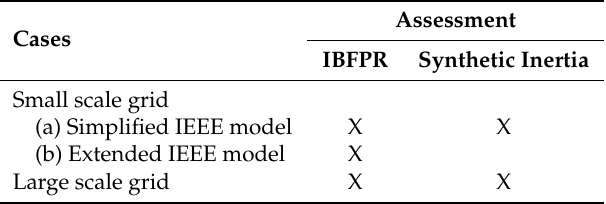
Table 2. Summary of the simulated cases.